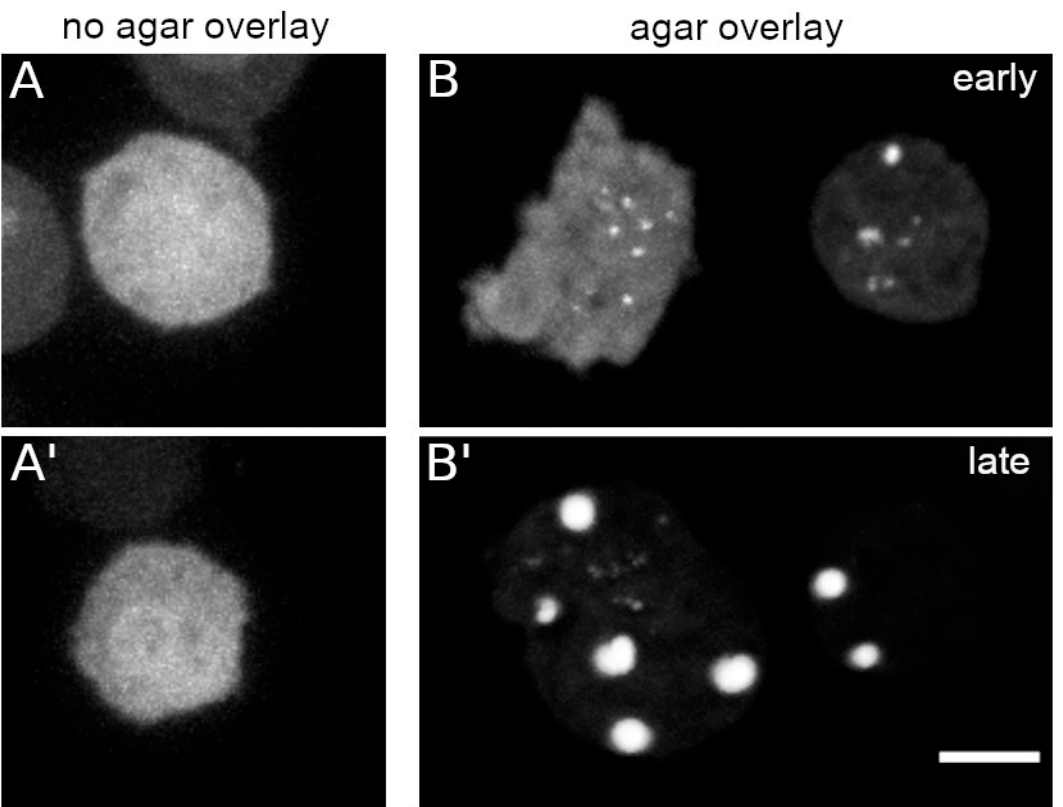
Figure 4. GFP-NE81-S122E ∆ NLS ∆ CLIM assembly is triggered by cell flattening. Confocal spinning disk live cell imaging in LoFlo medium: ( A , A’ ) two control examples prior to agar overlay; and ( B , B’ ) two examples with two cells each after cell flattening by agar overlay, ( B ) in an early phase up to 1 h and ( B’ ) in a late phase (after 1 h). Scale bar = 5 µm.